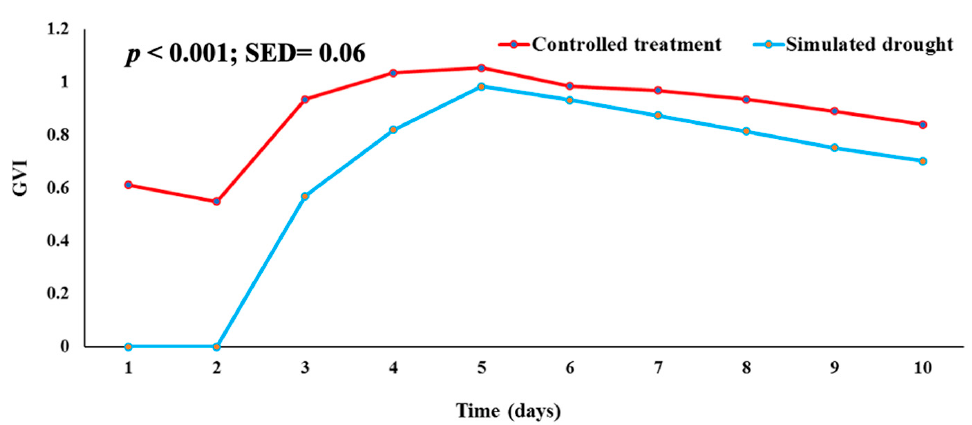
Figure 2. Germination velocity index (GVI) in each day subjected to simulated drought conditions using 5% PEG compared to a control treatment using distilled water .